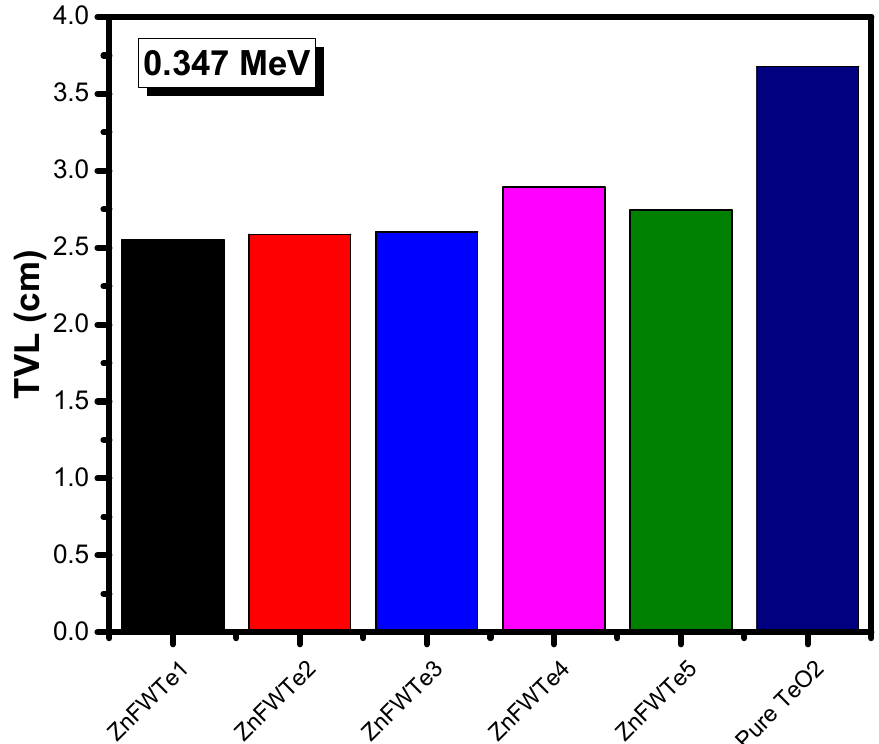
Materials 2022 , 15 , 2285 Figure 6. The tenth value layer for the selected oxyfluoride tellurite glasses at 0.347 MeV. At 0.284 MeV, for instance, one requires a 1.901-cm thickness of the sample ZnFWTe1 to decrease its intensity to one-tenth of its original (i.e., TVL), whereas 1.936, 1.956, 2.212, and 2.079 cm are required for glasses ZnFWTe2, ZnFWTe3, ZnFWTe4, and ZnFWTe5, re-